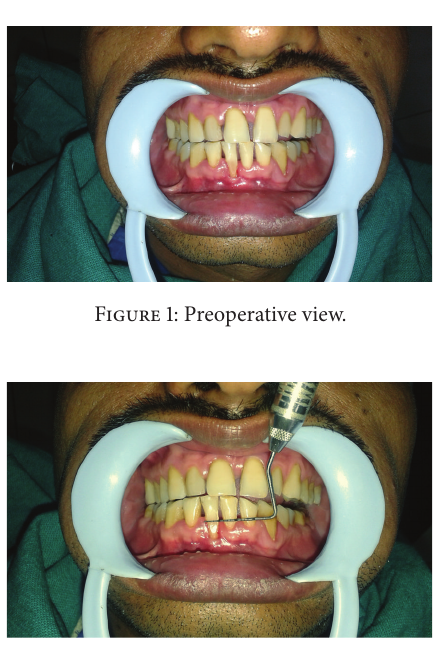
Figure 5: Periosteal Pedicle Flap raised by incomplete